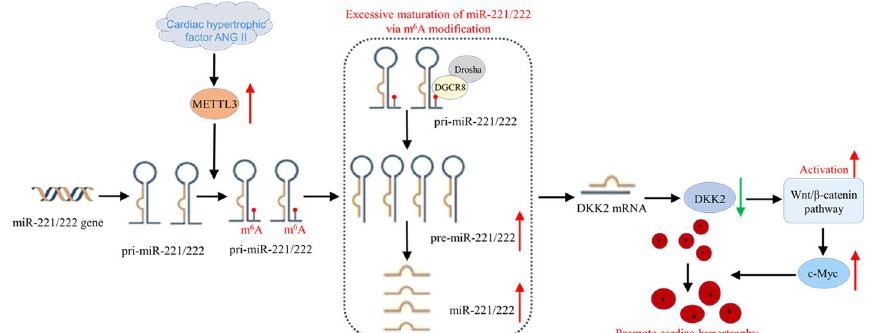
Fig. 8 Graphical abstract of the whole study. METTL3 in CMs was upregulated in response to Ang-II, promoting m6A modification on pri-miR-221/222, thus leading to increased miR-221/222 expression. Subsequently, DKK2 was inhibited and Wnt/β ‐ catenin/c-Myc pathway was activated, finally promoting myocardial